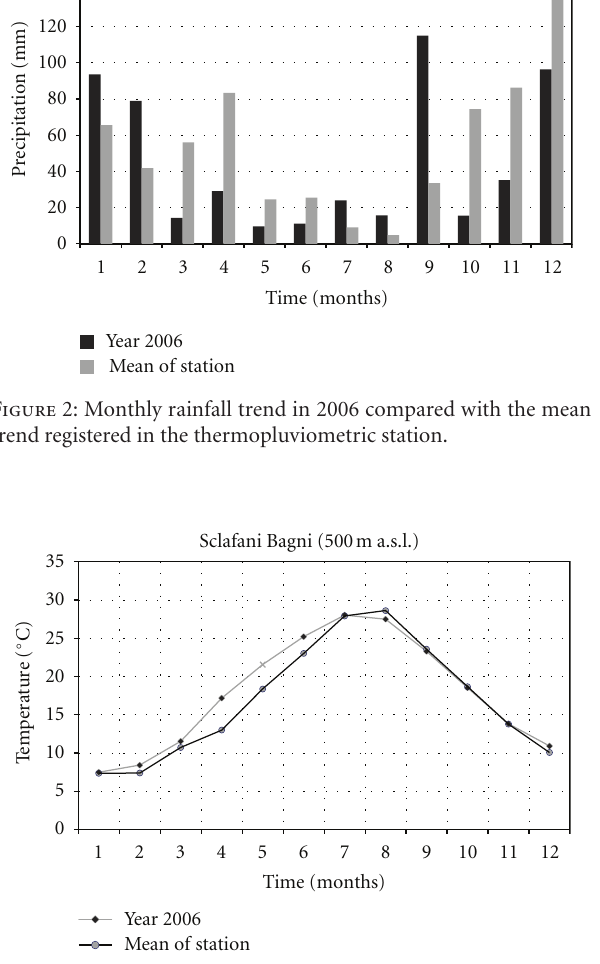
Figure 3: Soil mean temperature trend in 2006 compared with the mean trend registered in the thermopluviometric station.